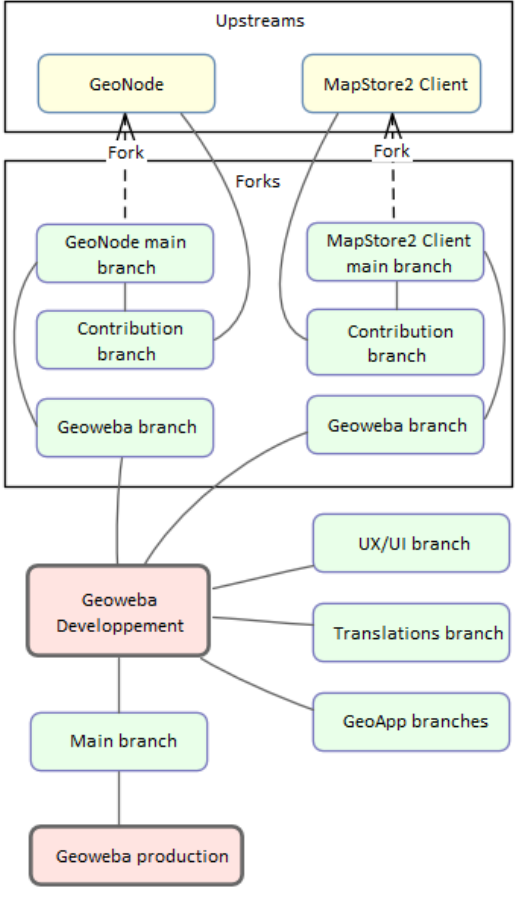
Figure 4 . Source code management and control with